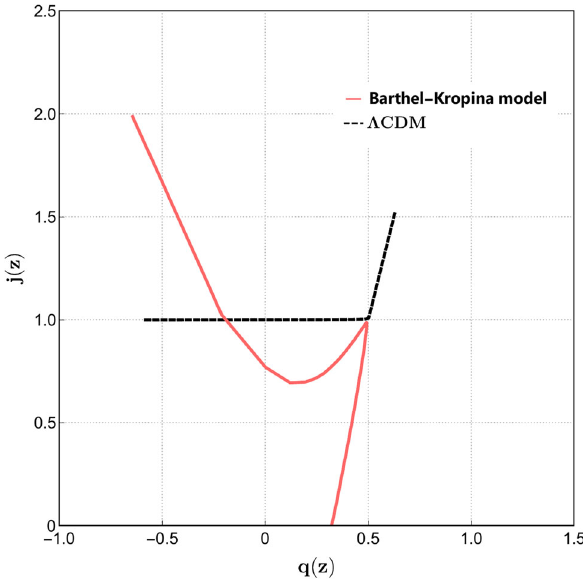
Fig. 9 The evolution of the jerk parameter j as a function of the decel- eration parameter q in the Barthel–Kropina and (cid:2) CDM models